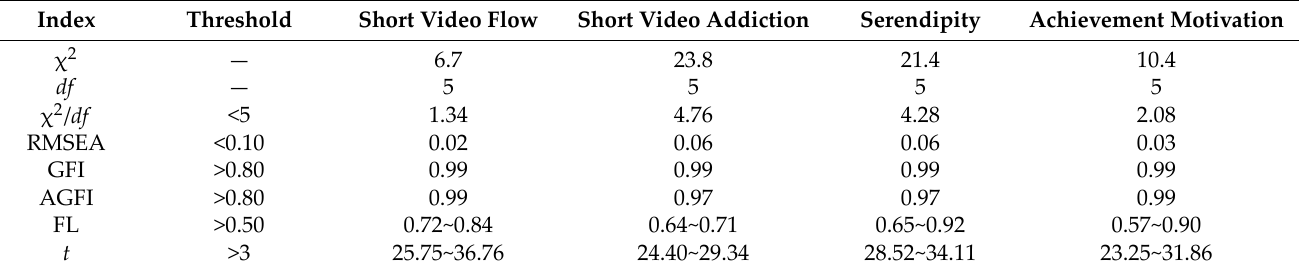
Table 1. First‑order Confirmatory Factor